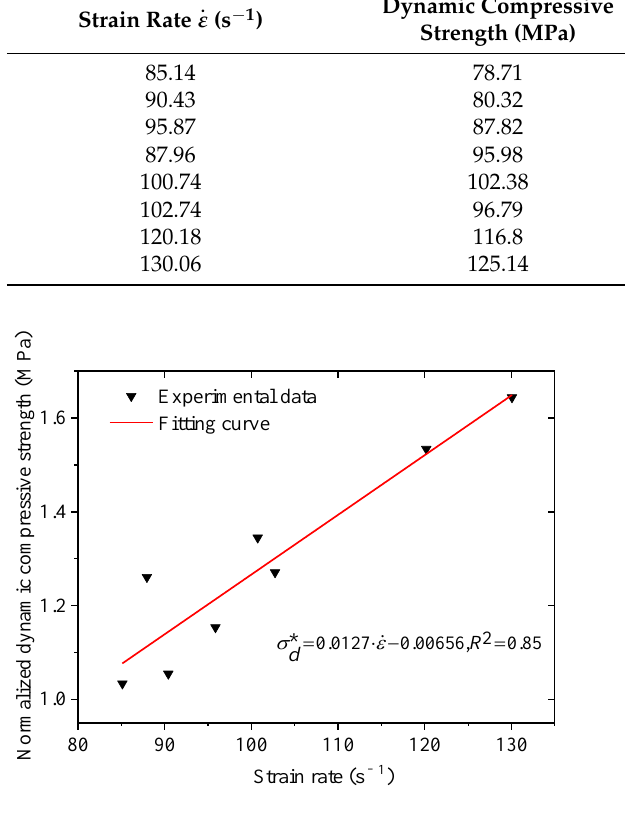
Figure 17. The relationship between σ d∗ and ε̇ for sandstone. The relationship between the stress amplitude and equivalent volumetric strain under impact loading is shown in Figure 18. The parameters related to the state equation are calculated as shown in Table 7.